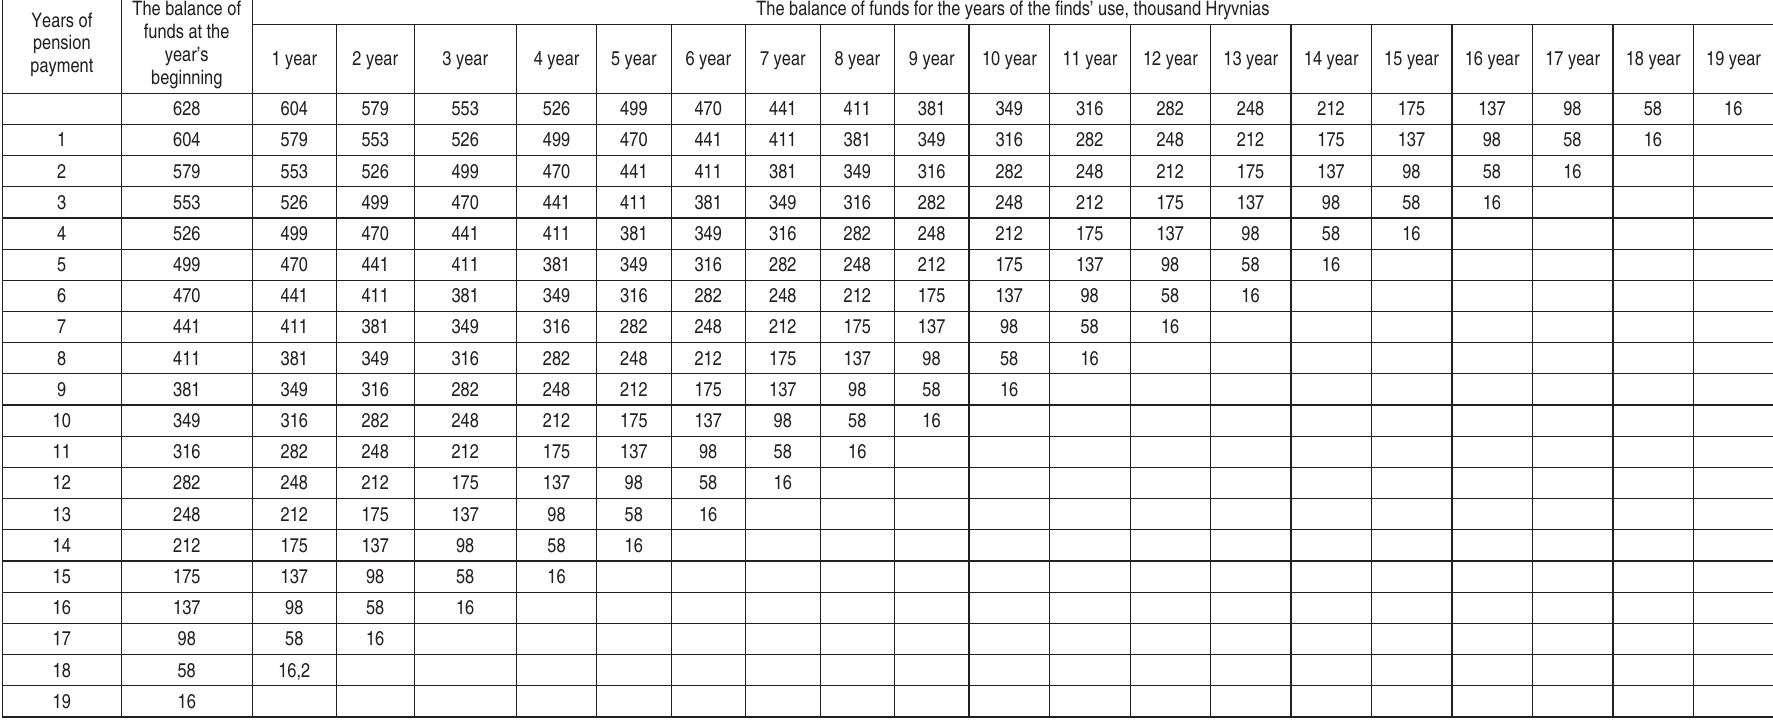
Table 3. Matrix of parameters for the use of funds of the accumulative pension